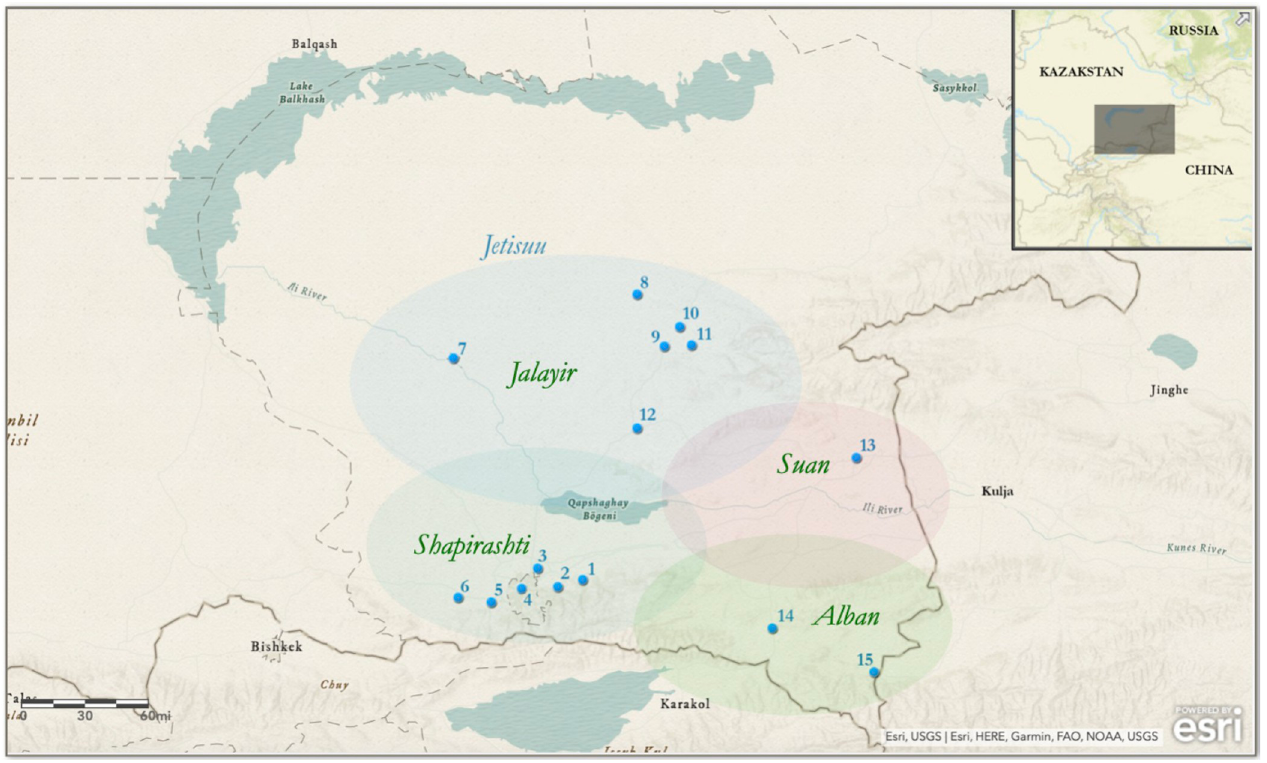
Fig 1. Map of Jetisuu and the sampling sites. 1. Engbekshi Kazak; 2. Talghar; 3. Ile; 4. Almati; 5. Karasay; 6. Jambil; 7. Balkash; 8. Karatal; 9. Ko¨ksuu; 10. Taldikorghan; 11. Eskeldi; 12. Kerbulak; 13. Panfilov; 14. Kegen; 15.